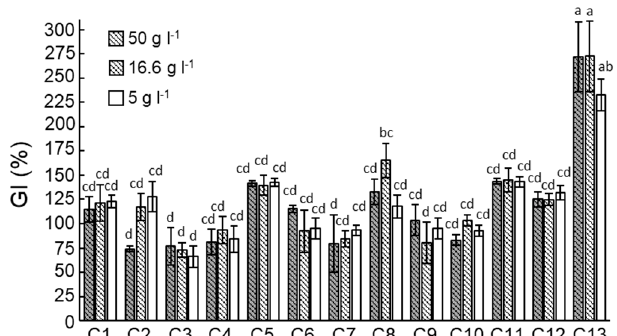
Figure A1. Compost phytotoxicity index. Evaluation of the cress germination index (GI%) on water extracts of composts (C1–13) at high, medium and low concentrations (50, 16.6 and 5 g l − 1 , respectively). Bars indicate the mean ± standard error. Different letters indicate significant differences among bars of the same concentration according Tukey's HSD test at p ≤ 0.05.